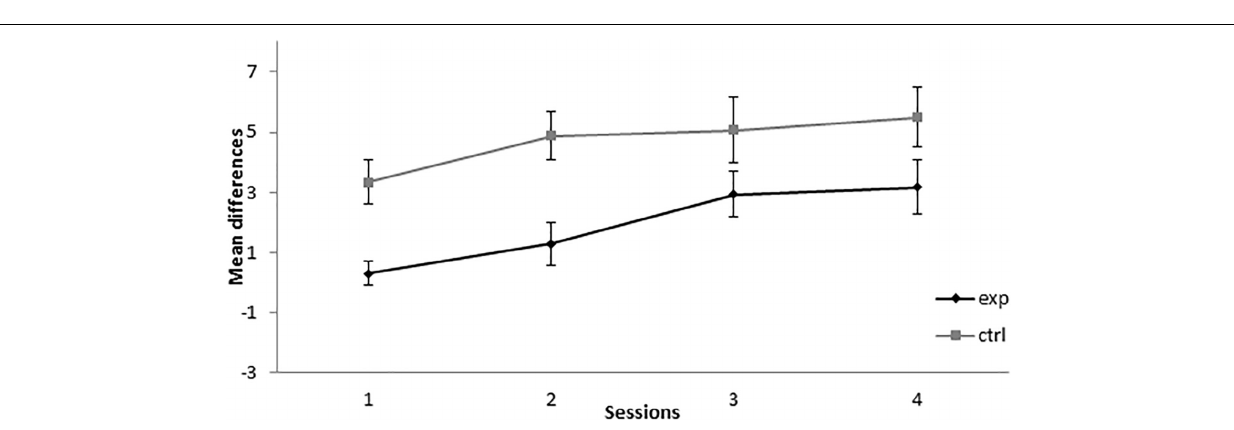
FIGURE 4 | Retardation test in Experiment 2. PreX-X differences ( ± SEM), averaged for the 10 X+ presentations per session in retardation, are displayed. The black line represents the group that was trained with eight A+, eight AX – , six F – , six F+, and two X – presentations per session in conditioning. The gray line represents